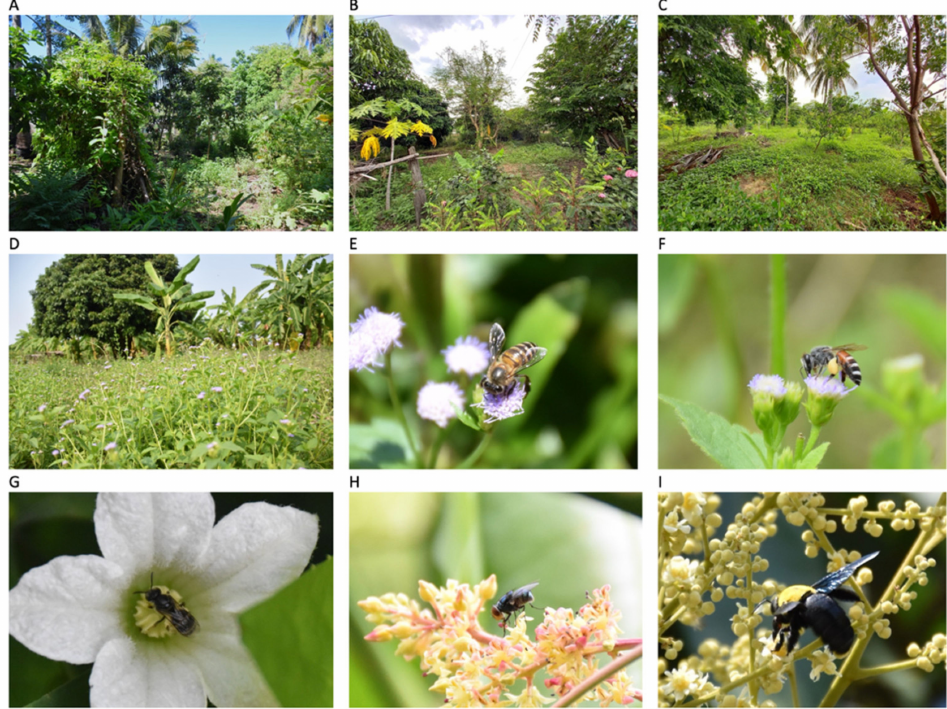
Figure 2. Example of the focal smallholder orchards ( A – C ), area invaded by Praxelis clematidea ( D ), and pollinators; Apis cerana ( E ), Apis florea ( F ), Halictid sp. ( G ), Lucilia sp. ( H ), and Xylocopa aestuans ( I